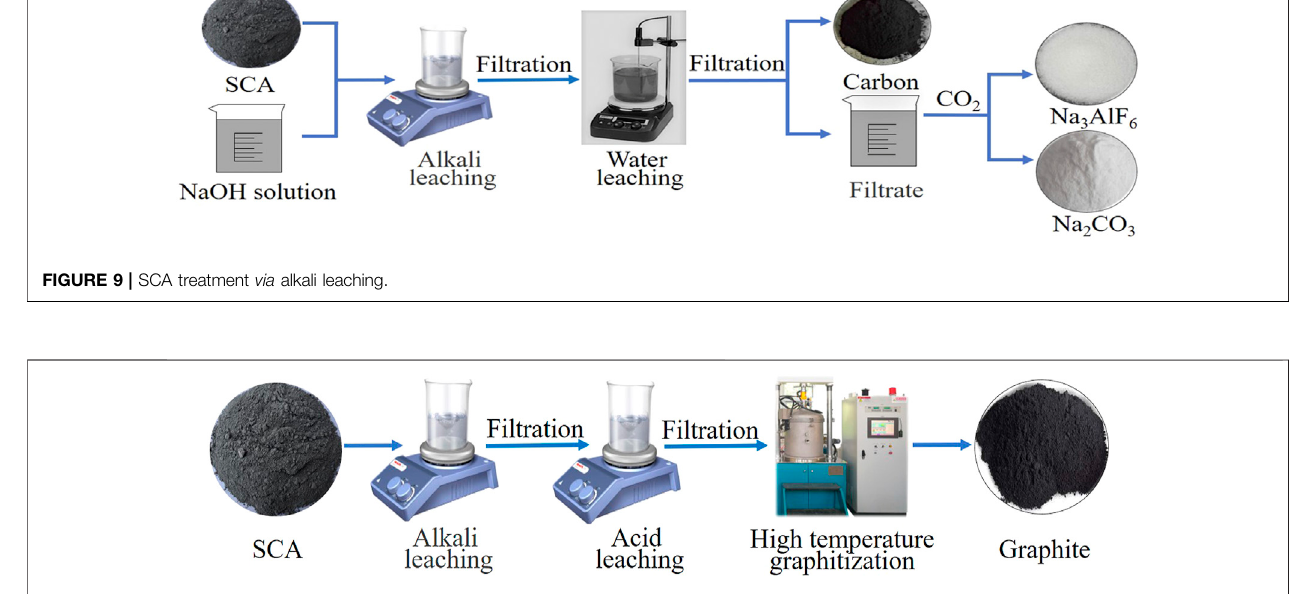
Frontiers in Energy Research |